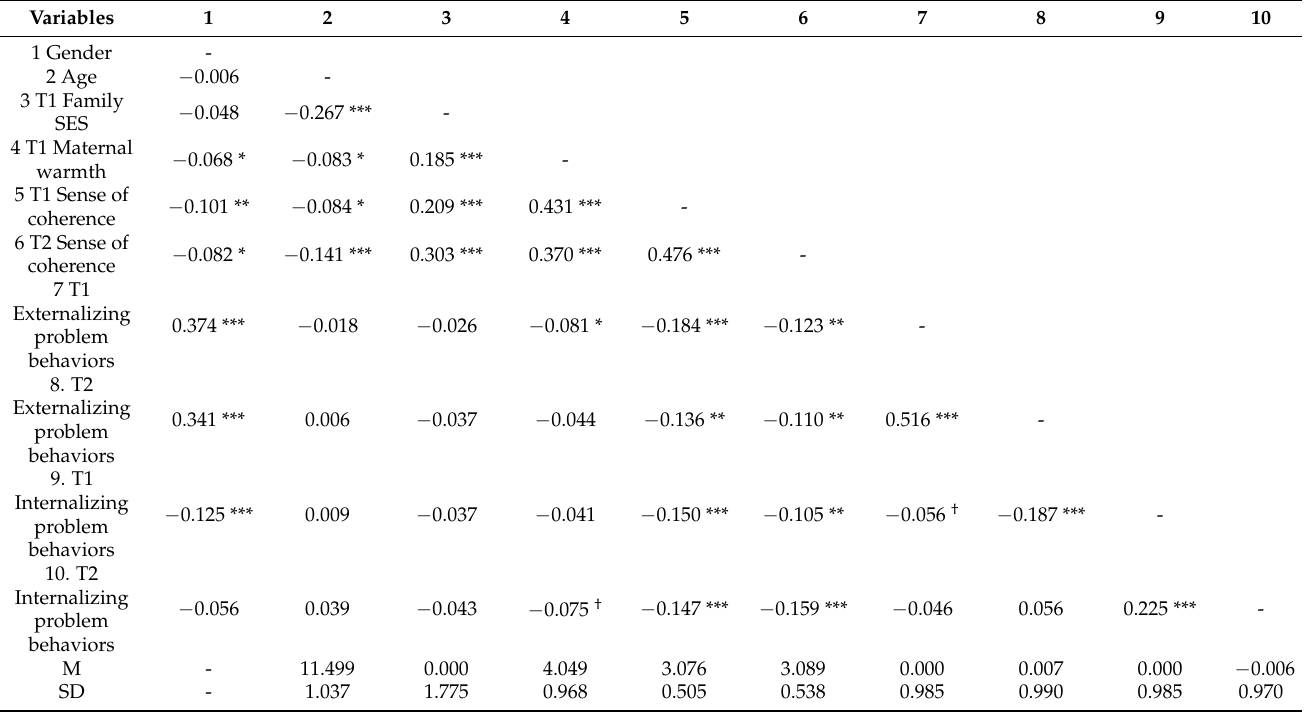
Table 1. Descriptive Statistics for Study